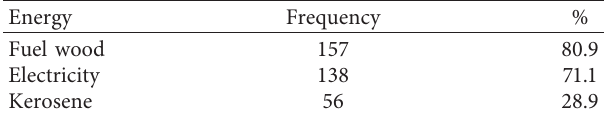
Table 3: Domestic energy utilization ( N � 194).